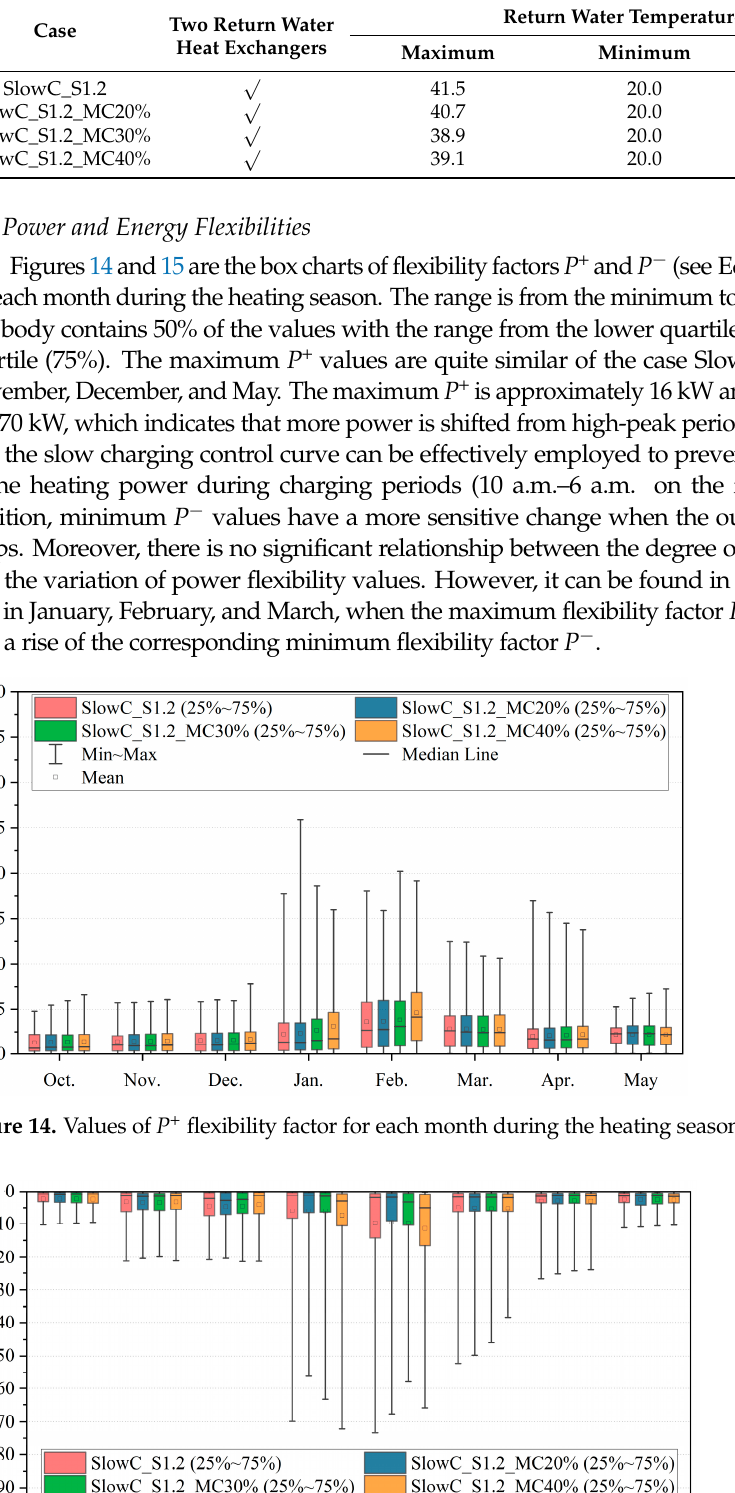
Table 6. Return water temperatures of peak shaving cases.